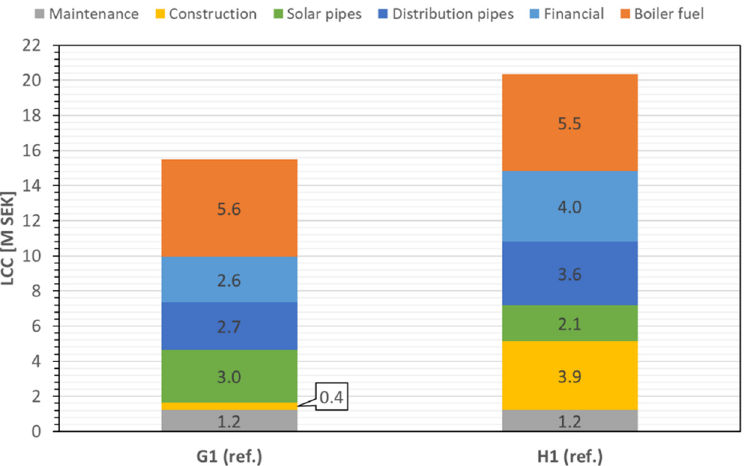
Figure 8. LCC analysis—Overview of the LCC of the two reference variants for the two distribution concepts simulated in this study with an economic lifetime of 20 years.